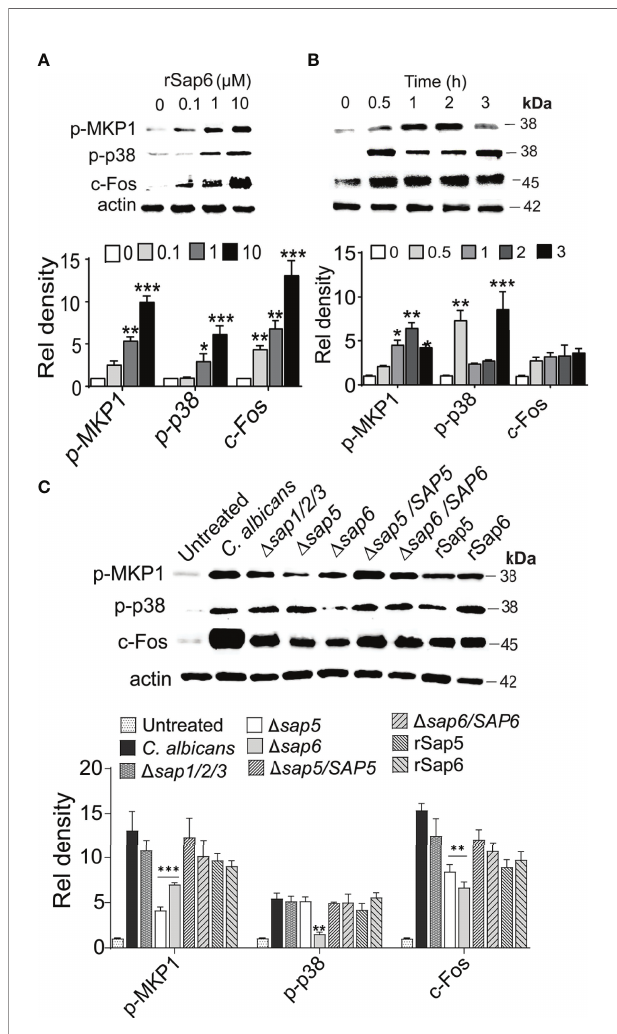
FIGURE 2 | rSap6 activates p-38, MKP1, and c-Fos MAPK signaling pathway (A) OECs were treated with rSap6 (0-10µM) for 3 h, then OEC cell lysates (20 µg) were immunoblotted using p-p38, p-MPK1 and c-Fos antibodies. rSap6 showed concentration dependent signi fi cant increase in MAPK phosphorylation and c-Fos activation, with 10µM rSap6 showing highest activation of OECs. (B) OECs were treated with rSap6 (10µM) for 0.5 - 3 h and cell lysates were immunoblotted. MKP1 phosphorylation gradually increased up to 2 h, then decreased at 3 h while p38 phosphorylation had an inverse response suggesting feedback between MKP1 and p38. (C) Candida albicans WT (SC5314) cells and SAP deletion strains along rSap5 (10µM) and rSap6 (10µM) were incubated with OECs for 3 h. There was no change in p38/MKP1 MAPK signaling